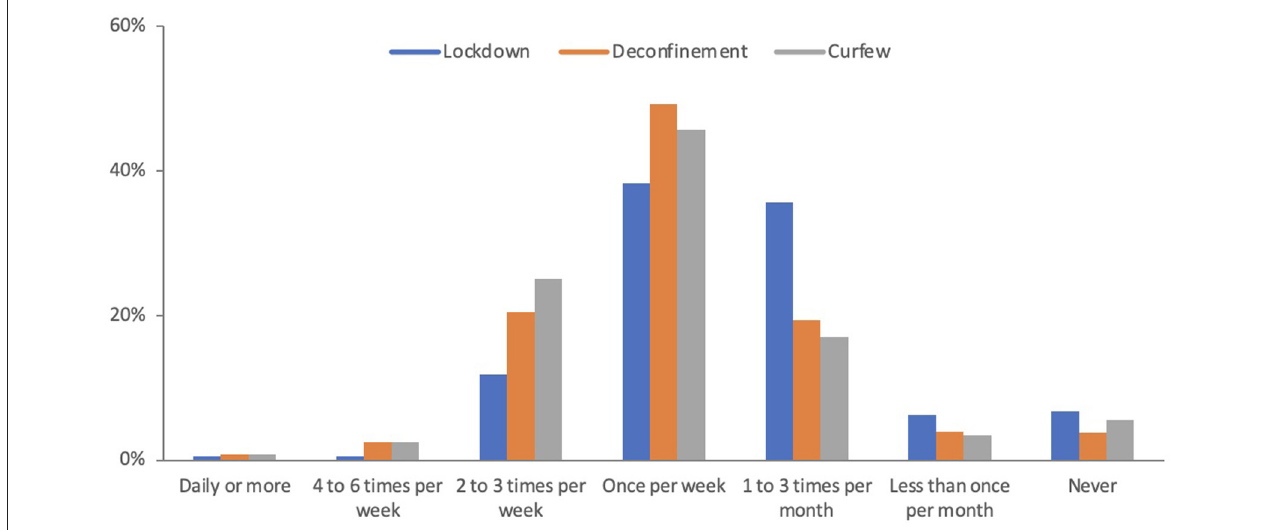
FIGURE 1 | Grocery shopping frequency over the COVID-19 pandemic. “Overall, between (time period) , how often did you/your household delegate physically go into astore to shop for groceries?” Wilcoxon signed-rank test: Lockdown vs. Deconfinement p < 0.001, Deconfinement vs. Curfew p =